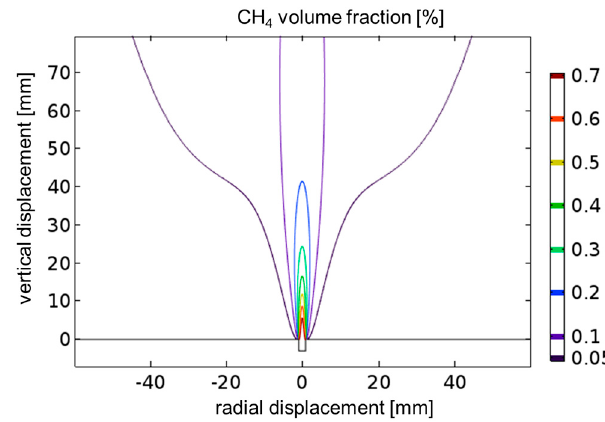
Figure 12. CFD simulation using COMSOL for a flux of 1% CH 4 in N 2 effusing from an orifice of 1 mm diameter with 100 mL/min into ambient air. An axial cut along the gas flow direction through the centrosymmetric laminar flow distribution shows iso-concentration lines of the CH 4 volume fraction.